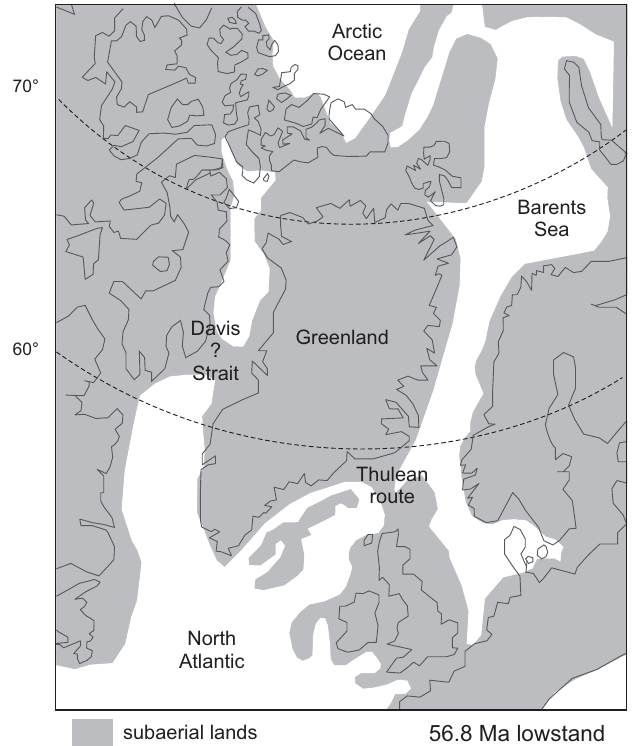
Fig. 10. Palaeogeography of the North Atlantic (Thulean) bridge during the sea-level lowstand in the Late Paleocene. The subaerial land connection (Davis Strait) between Baffin Island and central Greenland is under discus- sion. The much warmer climate and more southern position of the British Isles and Greenland facilitated dispersal of the thermophilic taxa between Europe and North America (modified from Brikiatis